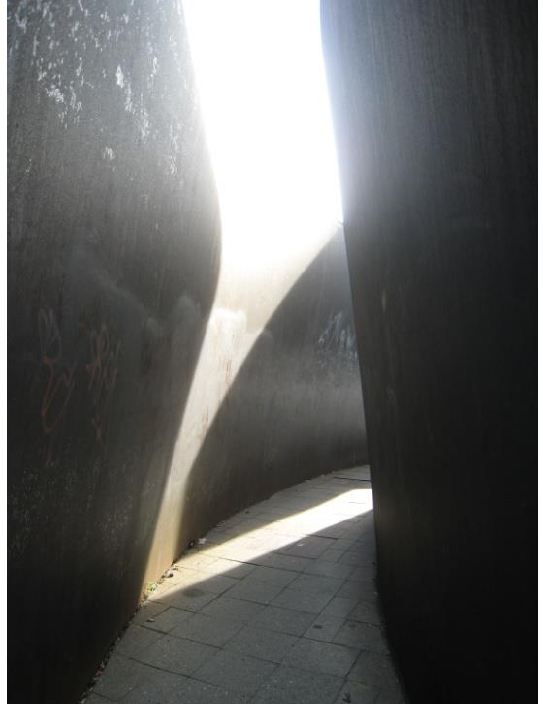
Figure 1. Richard Serra, Memorial to the victims of the Nazi T4 extermination program, Berlin. Material: corten plate (photo by Wojciech Targowski).